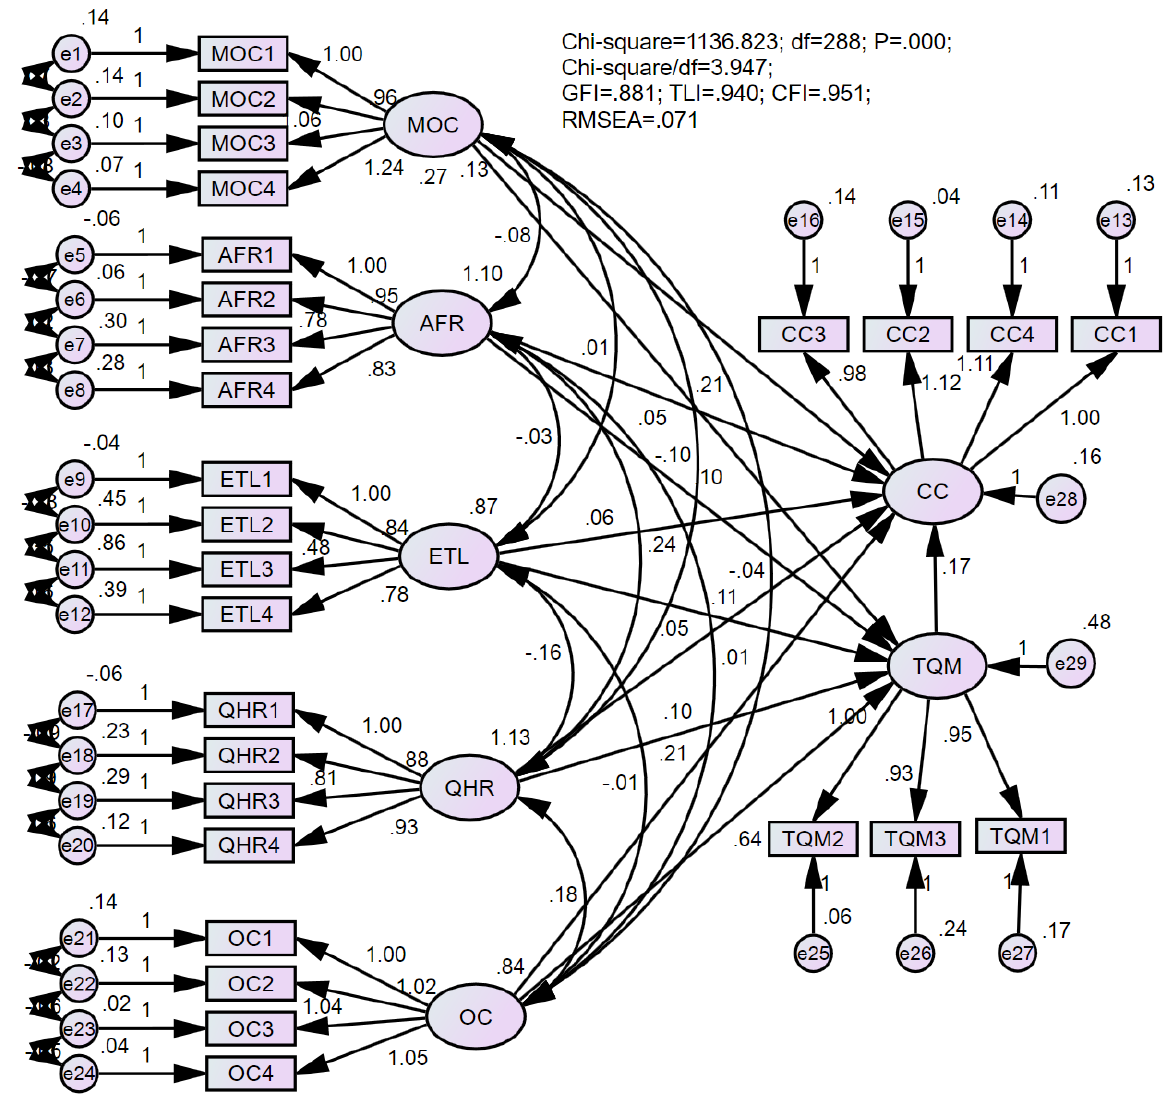
Figure 5. Testing factors affecting total quality management and competitive